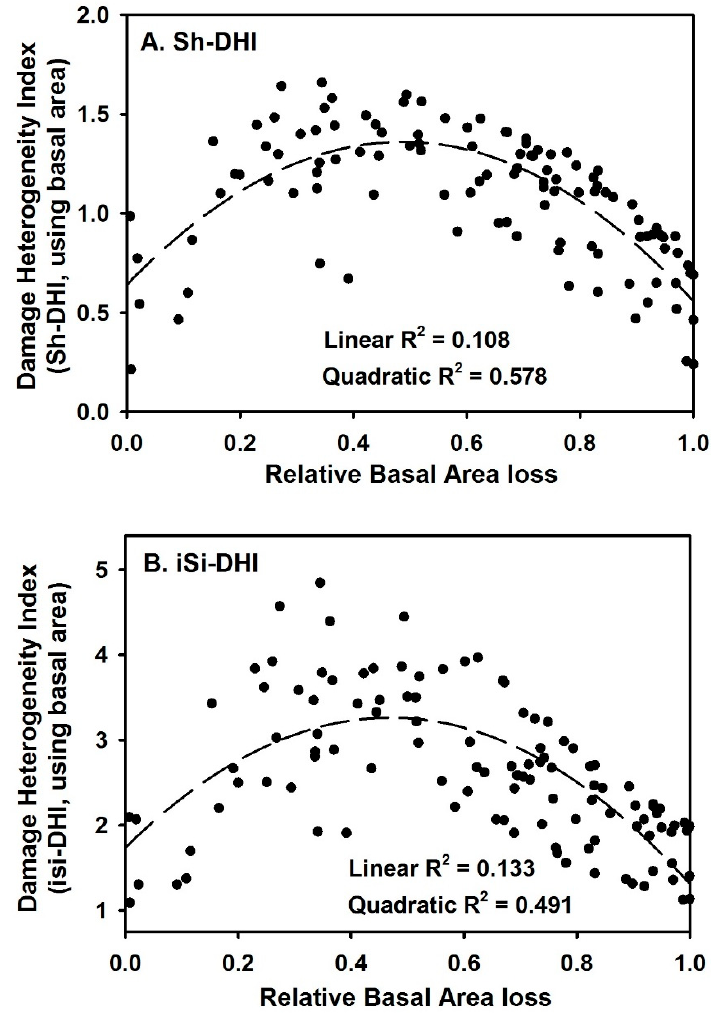
Figure 9. Damage heterogeneity index in relation to severity of damage, using plots sampled with 10-cm diameter minimum. ( A ) Sh-DHI, calculated with the Shannon index; ( B ) iSi-DHI, calculated with the inverse Simpson index. In all calculations of damage heterogeneity above, the measure of abundance used was the number of trees in each damage category for that plot. Variance explained (R 2 ) by linear and quadratic regressions were compared to determine if the relationship between DHI and severity was significatly curved.